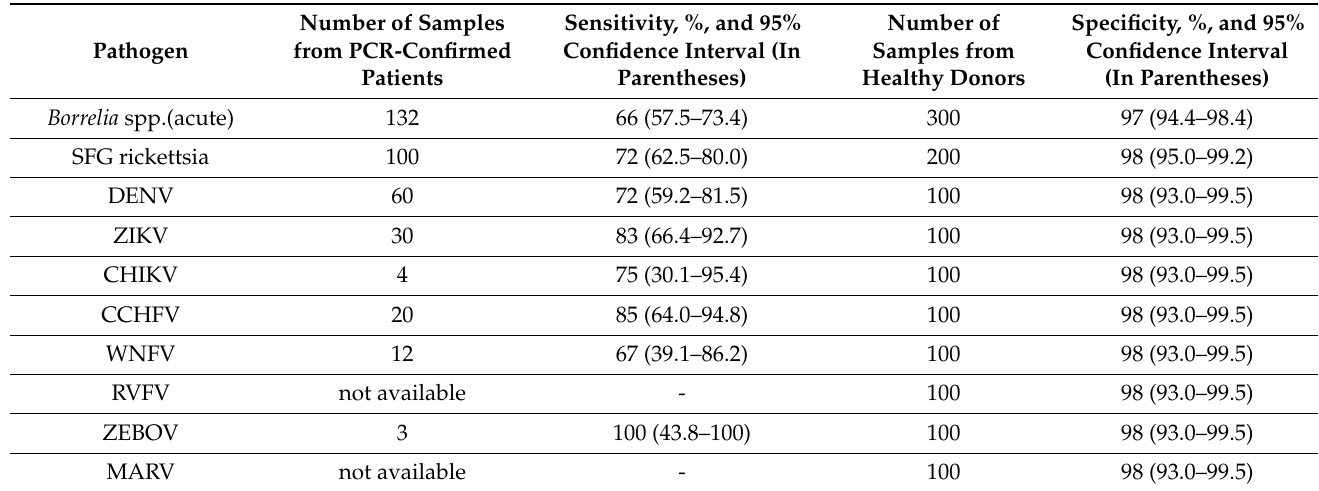
Table 3. Sensitivity and specificity of the protein microarray assay.